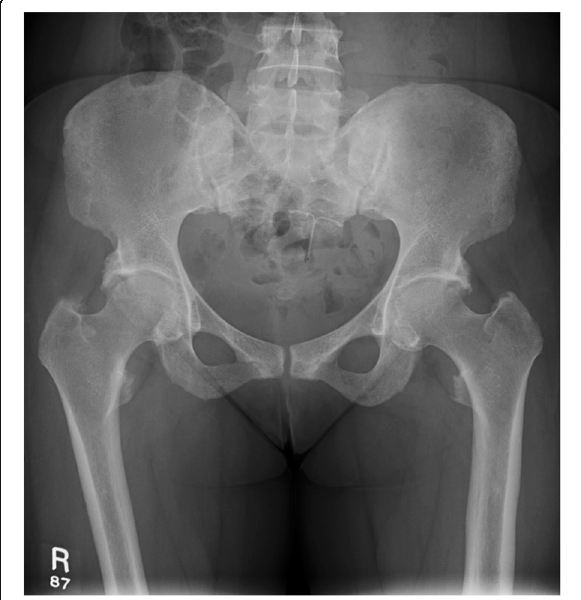
Fig. 5 The pelvic radiograph showed mild degree of osteoarthritis in both hip joints with femoro-acetabular impingement (cam and pincer